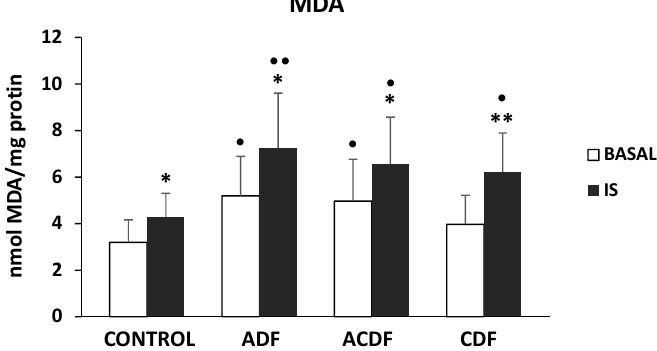
Figure 4. Intracellular malondialdehyde (MDA) levels under basal conditions and in response to indoxyl sulfate (IS; 256 µg/mL) in human THP-1 monocytes cultured in control solution (Hank’s medium) or in ADF (acetate 3 mM), ACDF (citrate 0.3 mM + acetate 0.8 mM), and CDF (citrate 1 mM) dialysates. Each column represents the mean ± SD of 5–8 independent experiments. * p < 0.05 and ** p < 0.01 vs. the value in the basal conditions. • p < 0.05 and •• p < 0.01 vs. the corresponding value in the control solution.